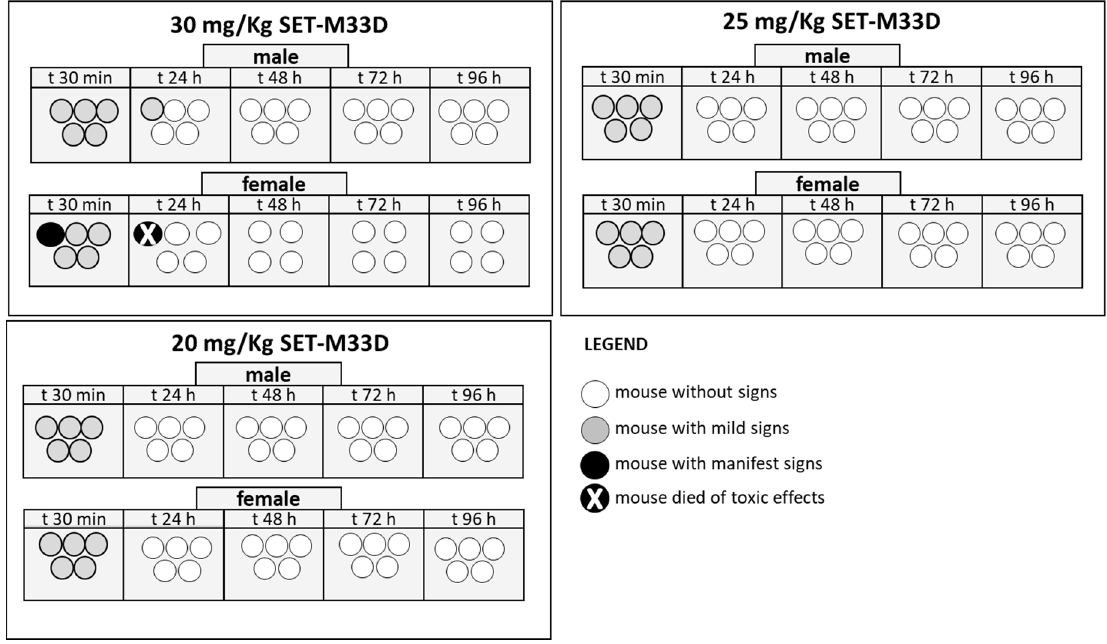
Figure 7. Acute in vivo toxicity of SET-M33D at 30, 25, and 20 mg/kg, given in a single dose. Ten mice/group (each circle represents a mouse), five males and five females, were inoculated i.v. with SET-M33D and were monitored for 96 h. Different scales of grey indicate severity of signs as described in the legend.